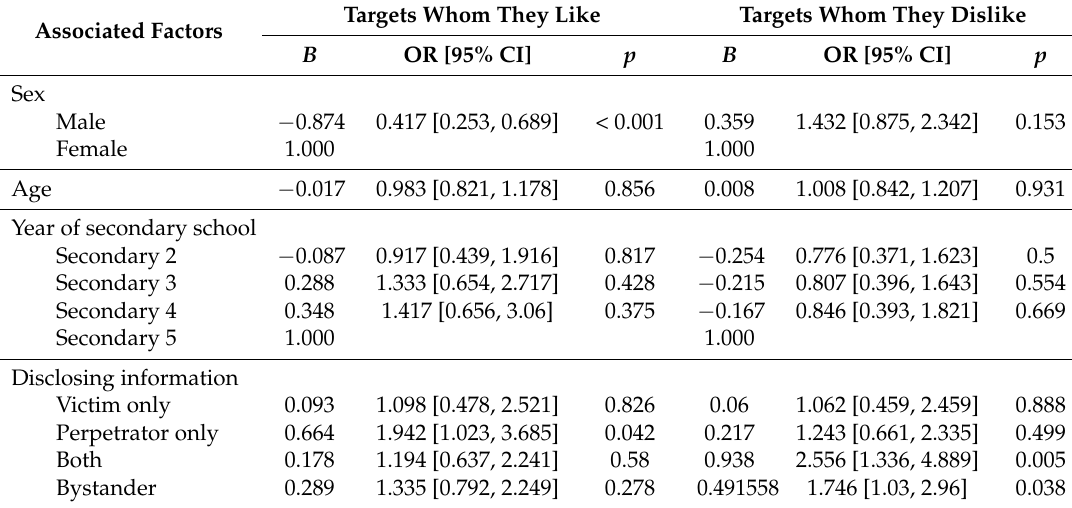
Table 5. Logistic regression of factors associated with doxing ( n =